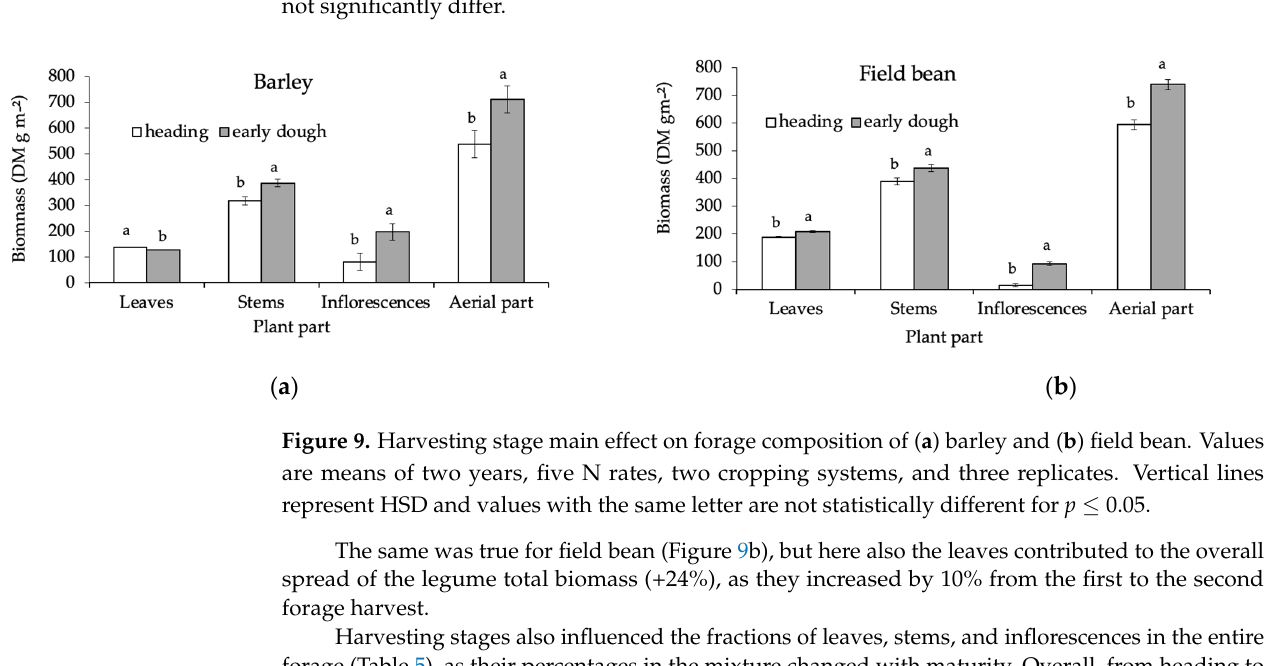
Table 5. Harvesting stage main effect on the distribution (%) of forage biomass among leaves, stems, and inflorescences of total, barley, and field bean forage.